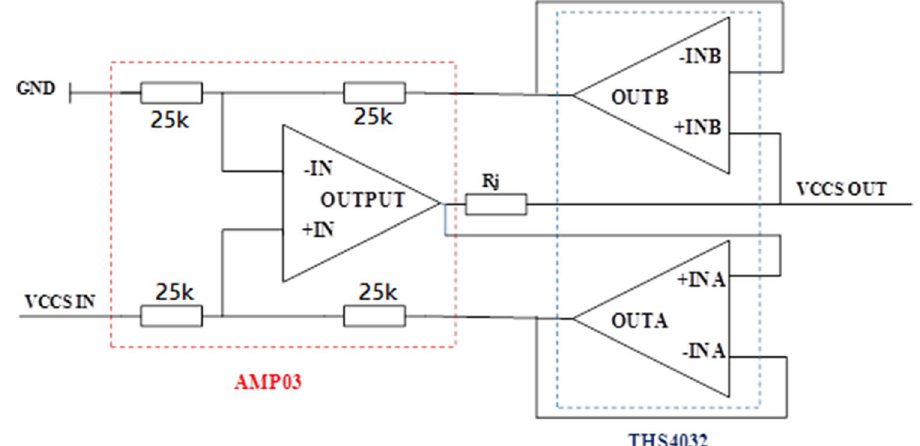
Figure 3. Illustration of the VCCS module circuit